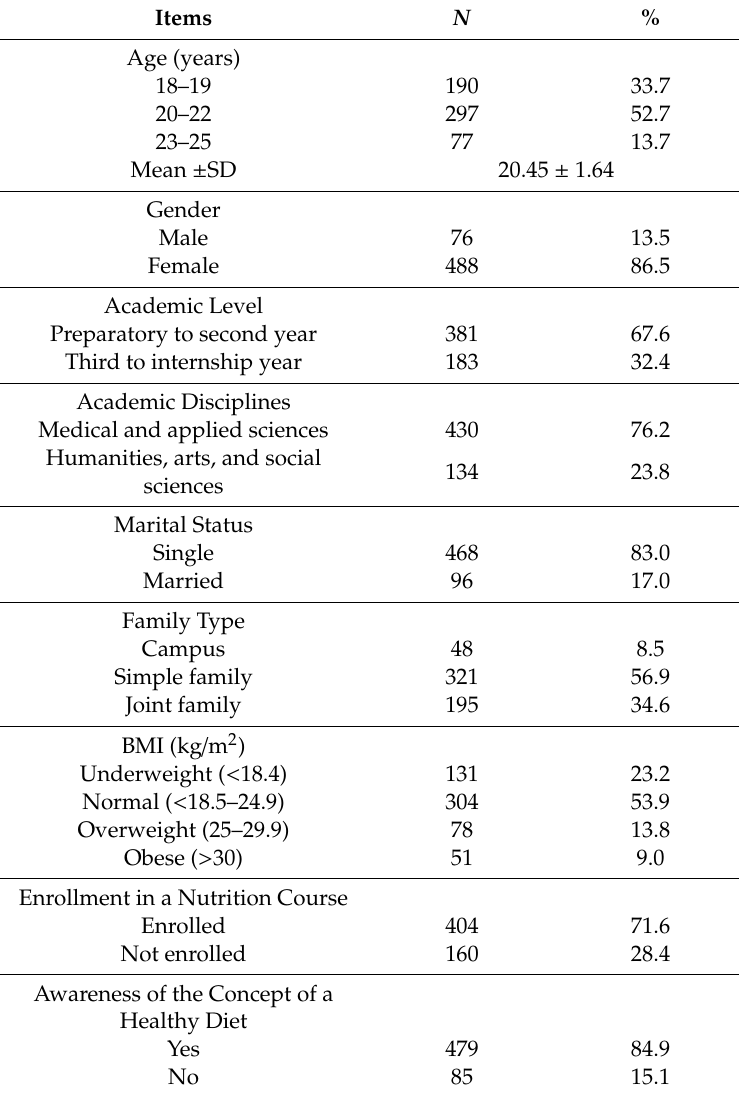
Table 1. Characteristics of the students ( n =